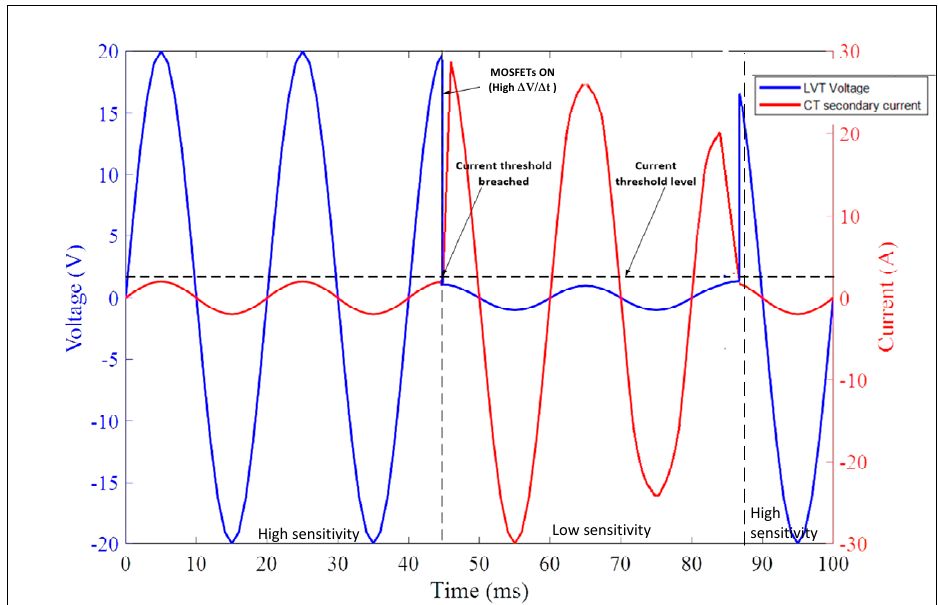
Figure 7. Example of fault current and corresponding LVT voltage signal. Note that the LVT voltage